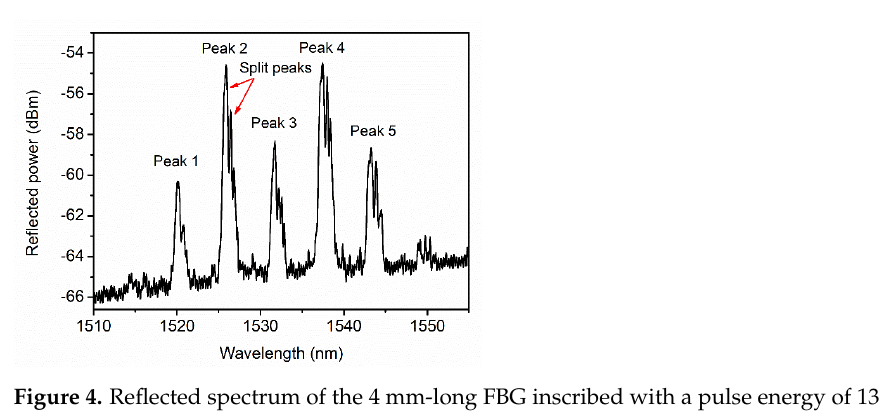
Figure 5. Experimental setup for strain measurement. 4.2. Experimental Results For FBG 1 obtained in the first regime, the strain introduced to the fiber was increased from 0% to 1.08%. The spectrum response to the applied strain is depicted in Figure 6a, and the Bragg wavelength versus strain is displayed in Figure 6b, showing a linear strain response with a sensitivity of 1.17 pm/ με ± 0.02 pm/ με via linear regression. For FBG 2 obtained in the second regime, the strain applied to the fiber was set from 0% to 1.05%. The spectra of peaks 1 – 7 in terms of strain are shown in Figure 7a – g, respectively, and the shifts in the Bragg wavelengths in response to the strains are shown in Figure 7h. After linear regression, the sensitivity (slope) is shown in Table 2. It was found that the strain sensitivity increased with the Bragg wavelength, from 1.249 pm/ με for ~ peak 1 to 1.296 pm/ με for peak 7.